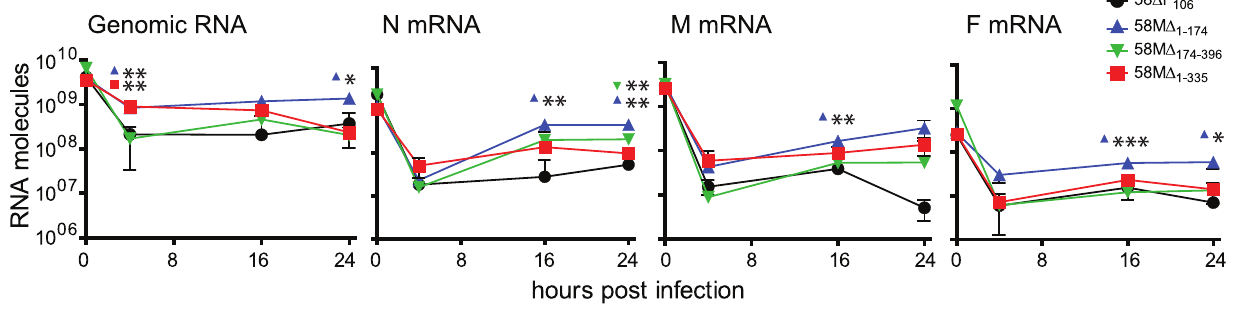
Figure 5. Effects of the M 3 9 UTR on early transcription and replication. Quantitative real-time RT-PCR analysis of viral genome and N, M and F mRNA. VerodogSLAMtag cells were infected with the parental and recombinant viruses at a MOI of 1. RNA was extracted after 0, 4, 16 and 24 h and subjected to reverse transcription. Primer pairs specific to the CDV trailer, N, M and F genes were used. The number of RNA molecules in the sample was quantified by plotting the Ct values against standard curves. Error bars indicate the standard deviation. *, P , 0.05, **, P , 0.01, and ***, P ,